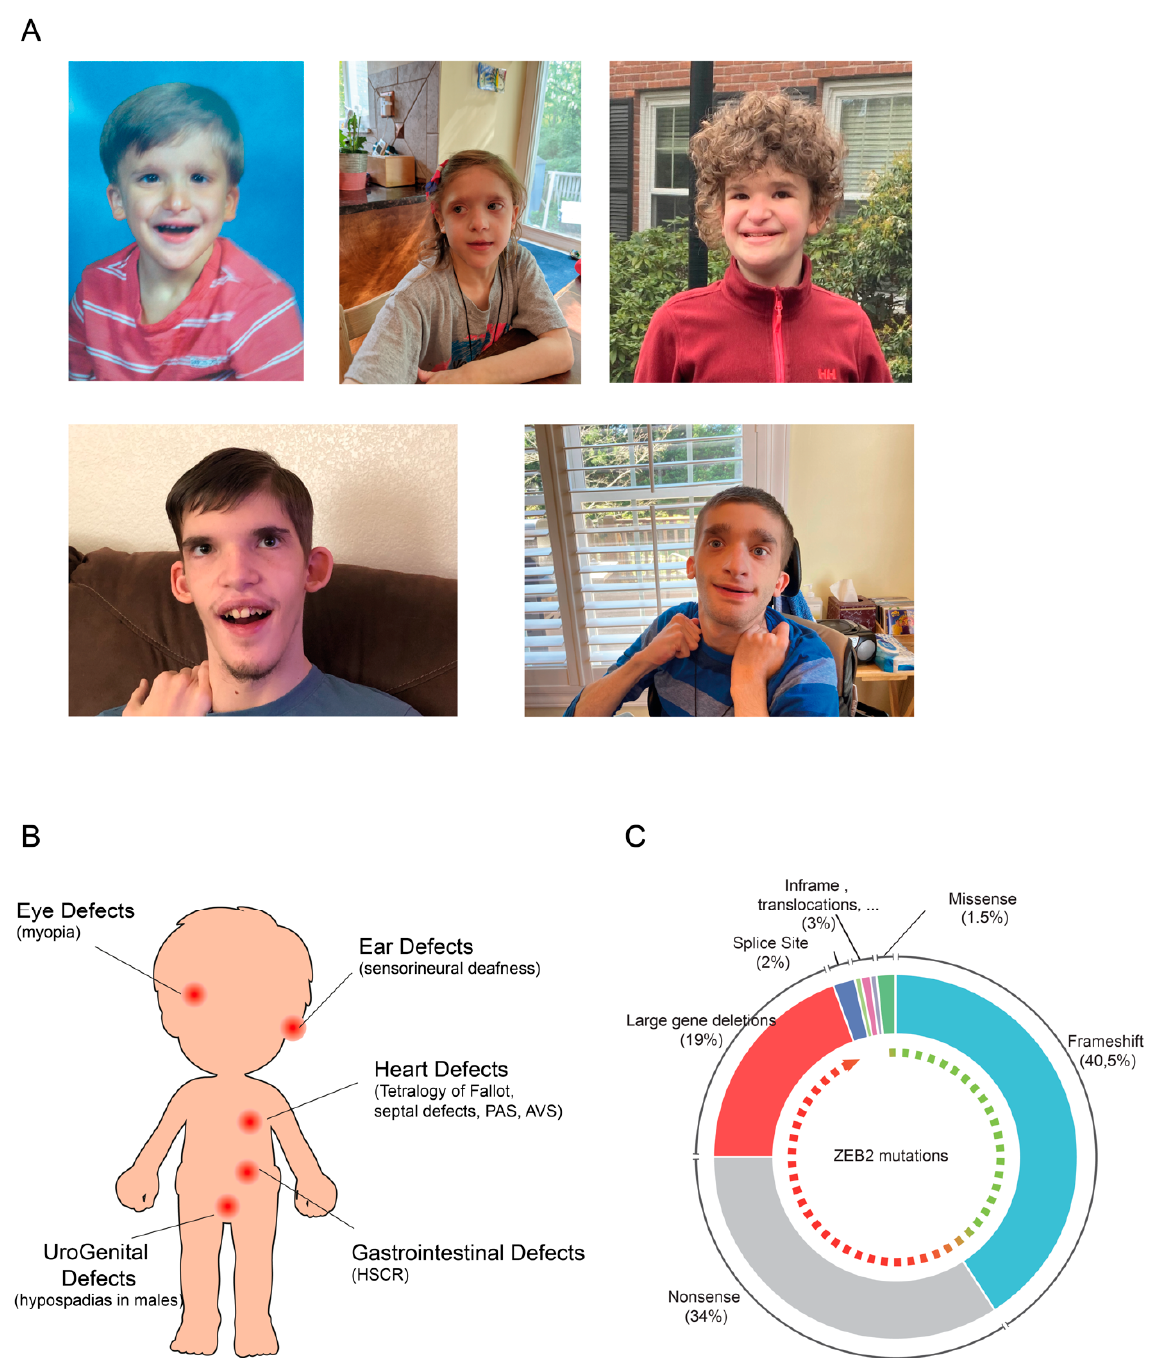
Figure 1 . Clinical features of MOWS patients and percentage of observed ZEB2 mutations: ( A ) MOWS patients show typical facial features (courtesy of the Mowat-Wilson Syndrome Foundation); ( B ) congenital defects associated with MOWS; ( C ) Reported ZEB2 mutations. The green to red dashed arrow inside represents the severity of the disease with green being mild to red being very severe.